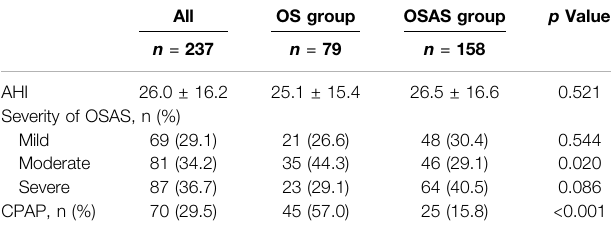
TABLE 3 | Baseline polysomnography data and treatment.